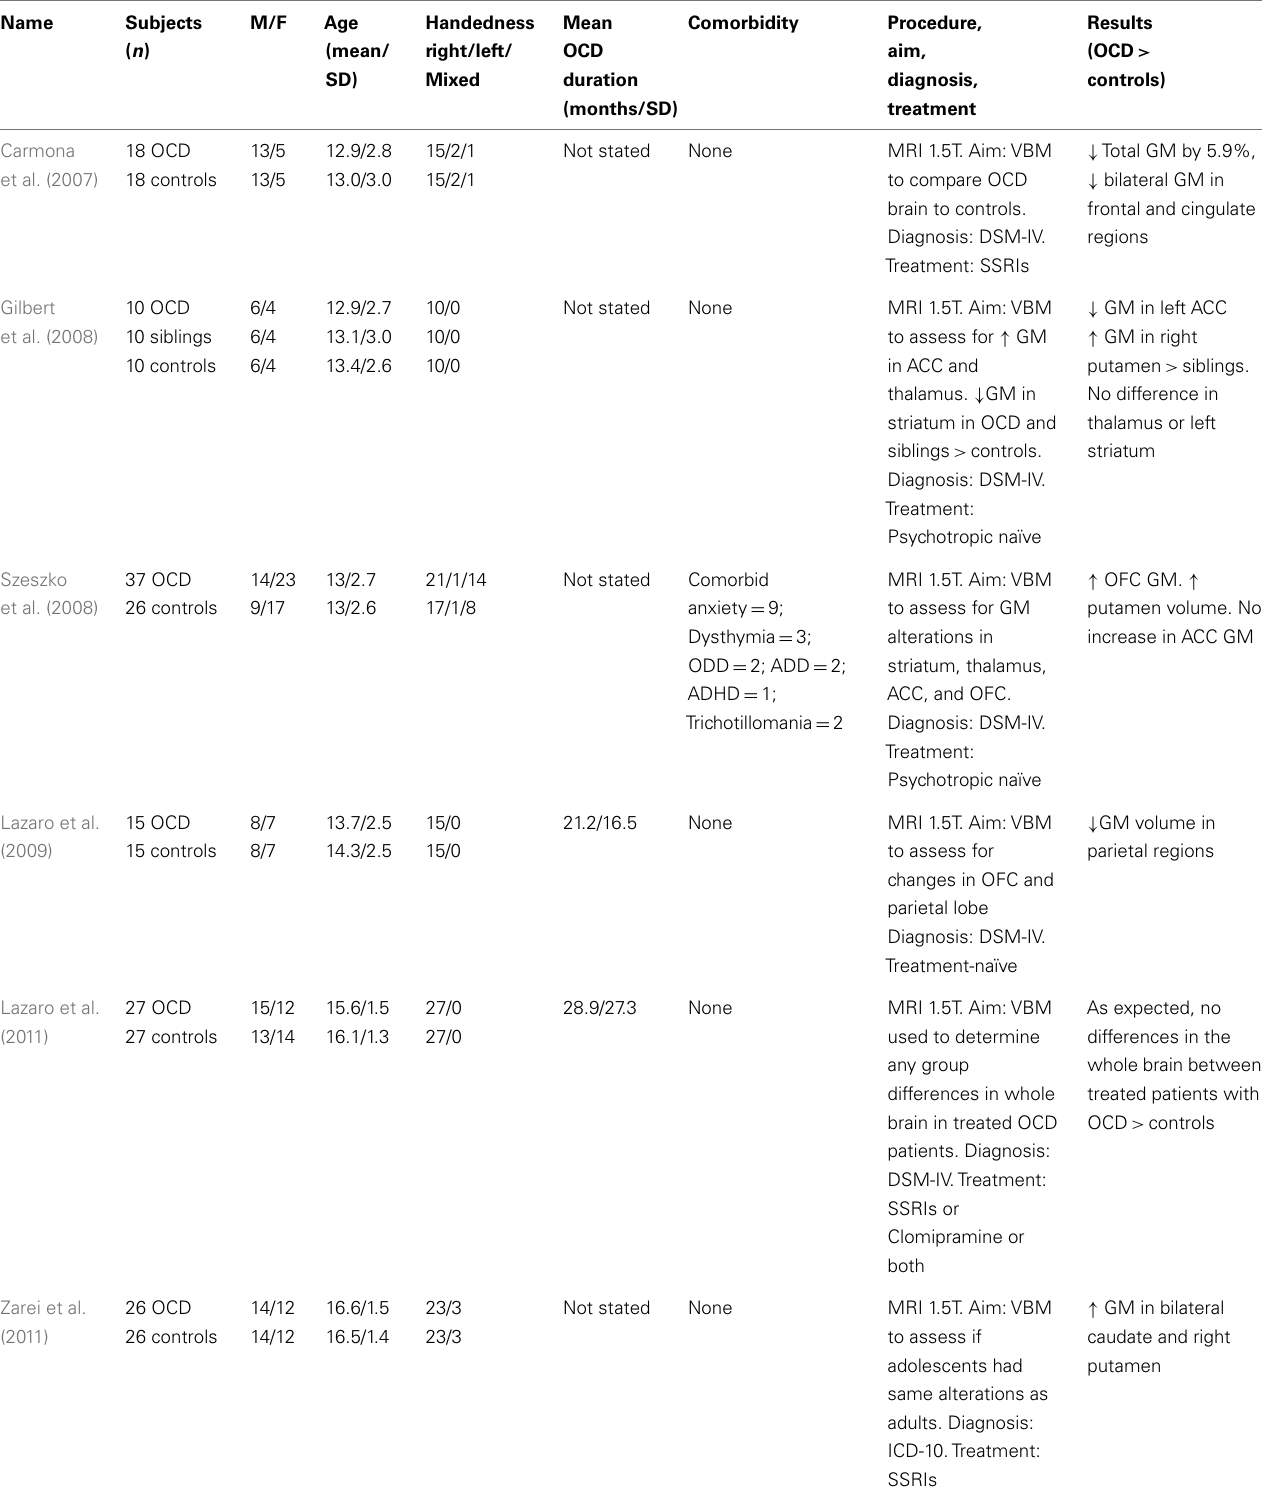
Table 2 | Structural magnetic resonance imaging studies in OCD.